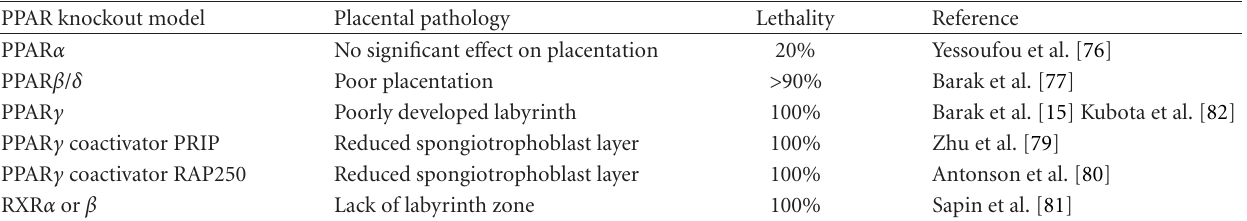
Table 3: PPAR knock out models and placental pathology (PRIP: peroxisome proliferator-activated receptor-(PPAR) interacting protein; RAP 250: nuclear receptor-activating protein